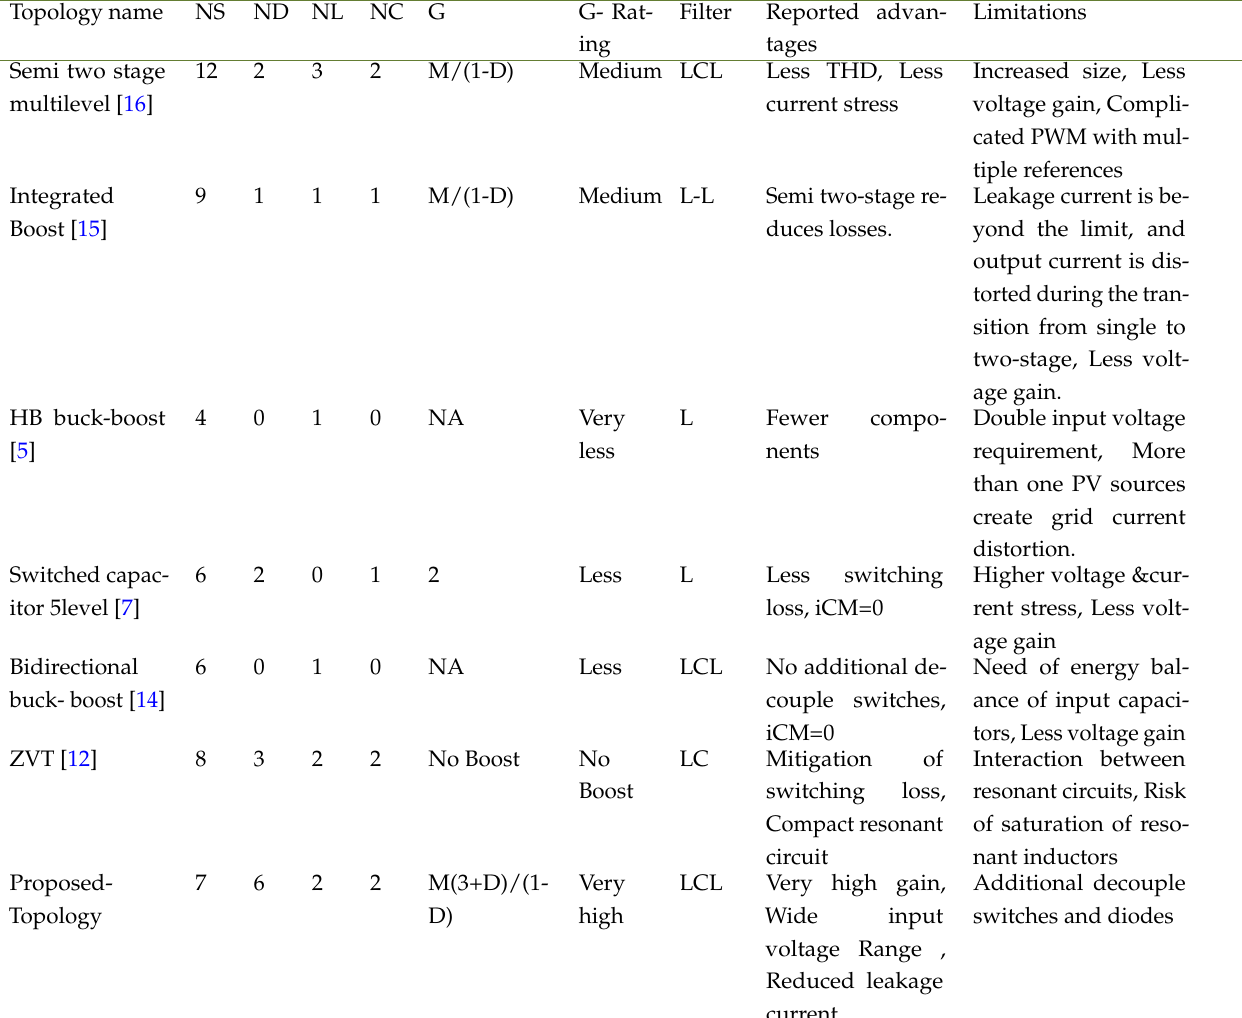
Table 3. Comparison of existing topologies with proposed